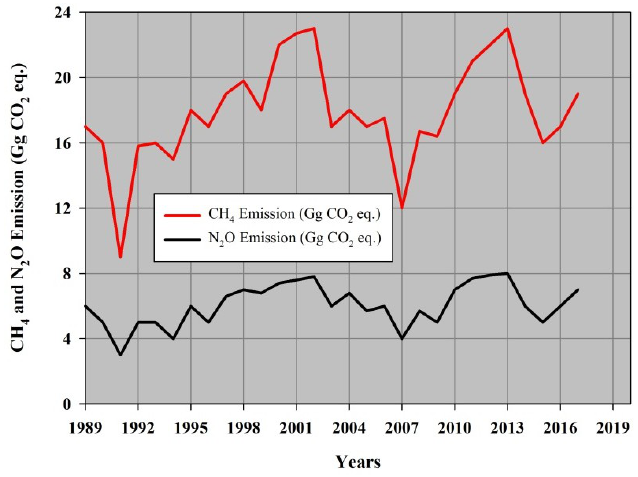
Figure 11. Value of CO 2 eq. emissions of CH 4 and N 2 O from the oil refining industry in Iraq from 1989 to 2017.